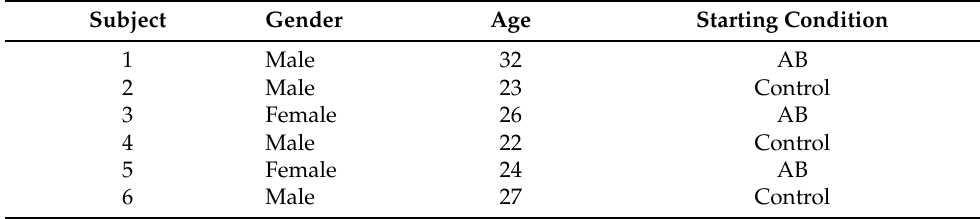
Table 1. Information of each participant.